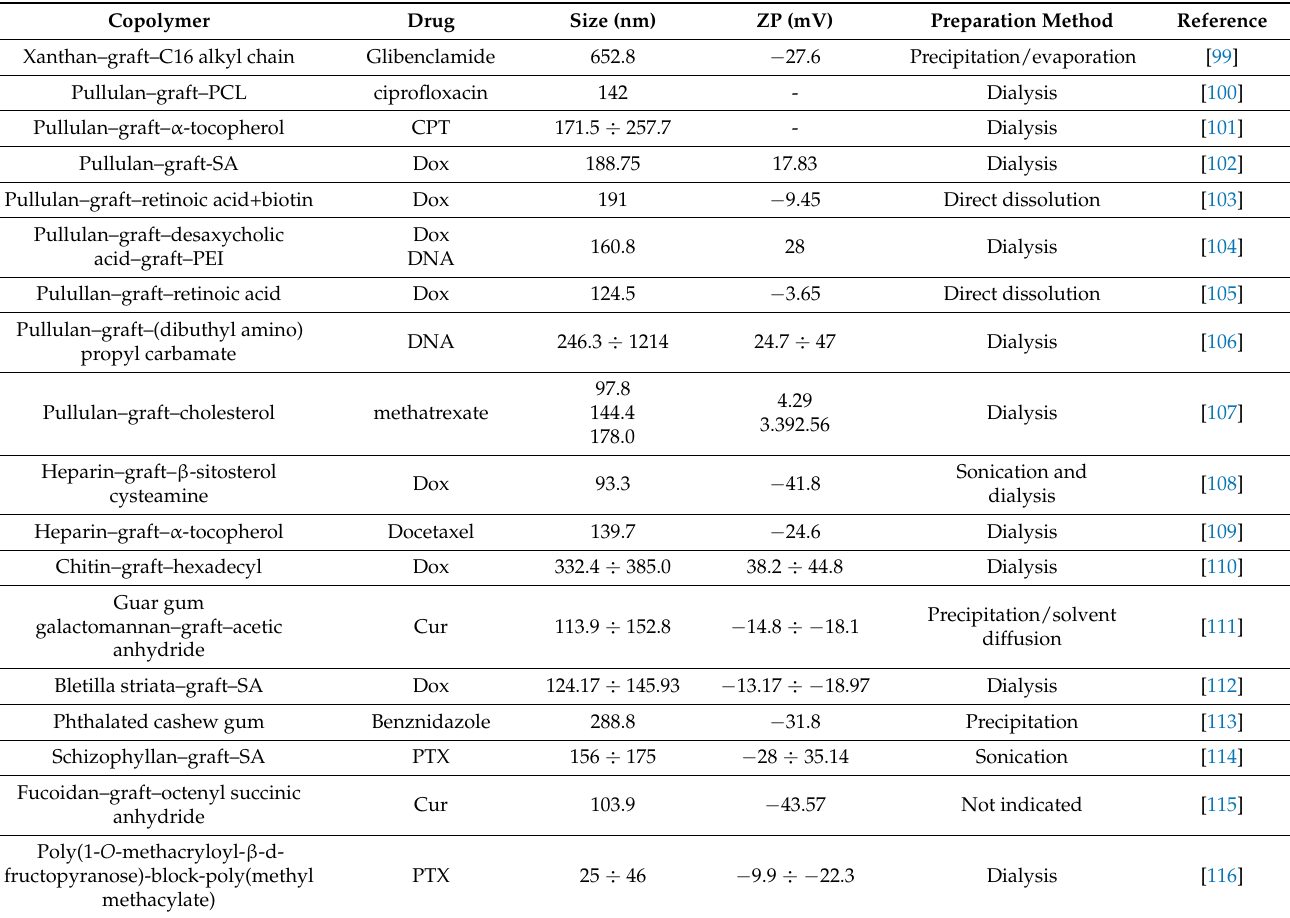
Table 3. Drug delivery systems based on miscellaneous